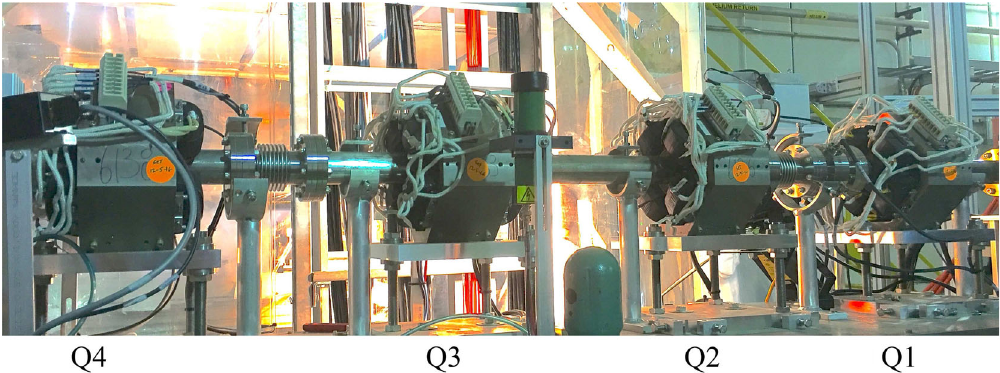
FIG. 10. CeC modulator section comprising four quadrupoles. The electron beam propagates from right to